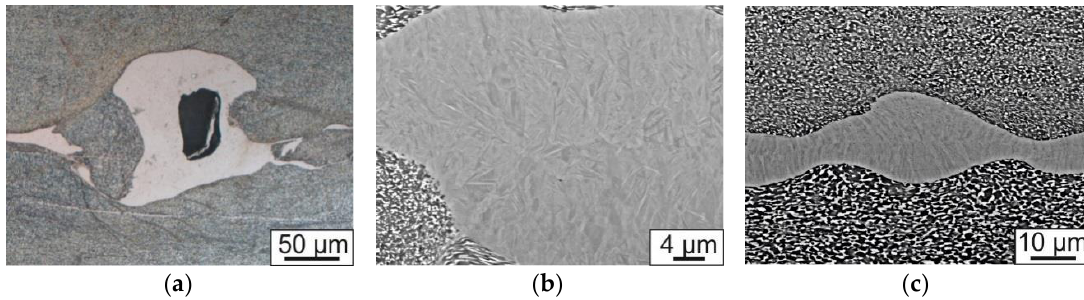
Figure 6. Quenched structure of vortices formed at VT23–VT14 interfaces: ( a ) light microscopy image; ( b , c ) SEM images.